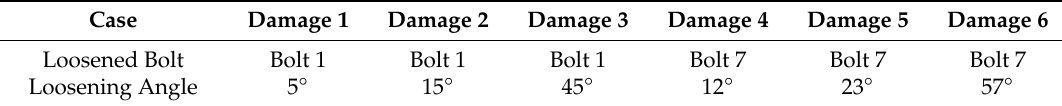
Table 1. Bolt-loosening test of lab-scaled bolted connection model.